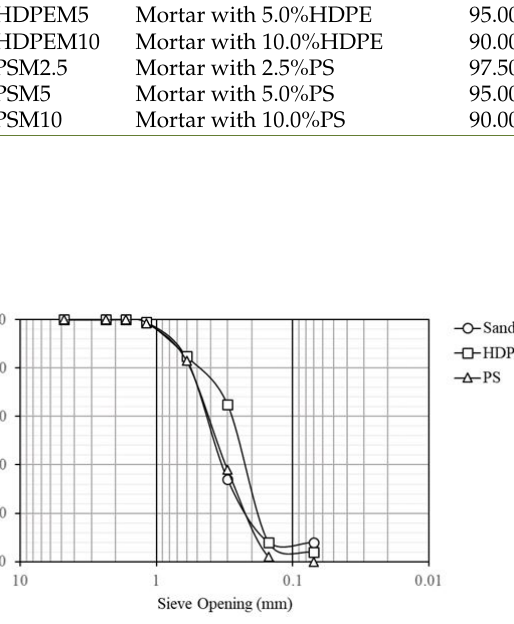
Fig. 2. Size distribution of recycled plastic waste com- pared to sand